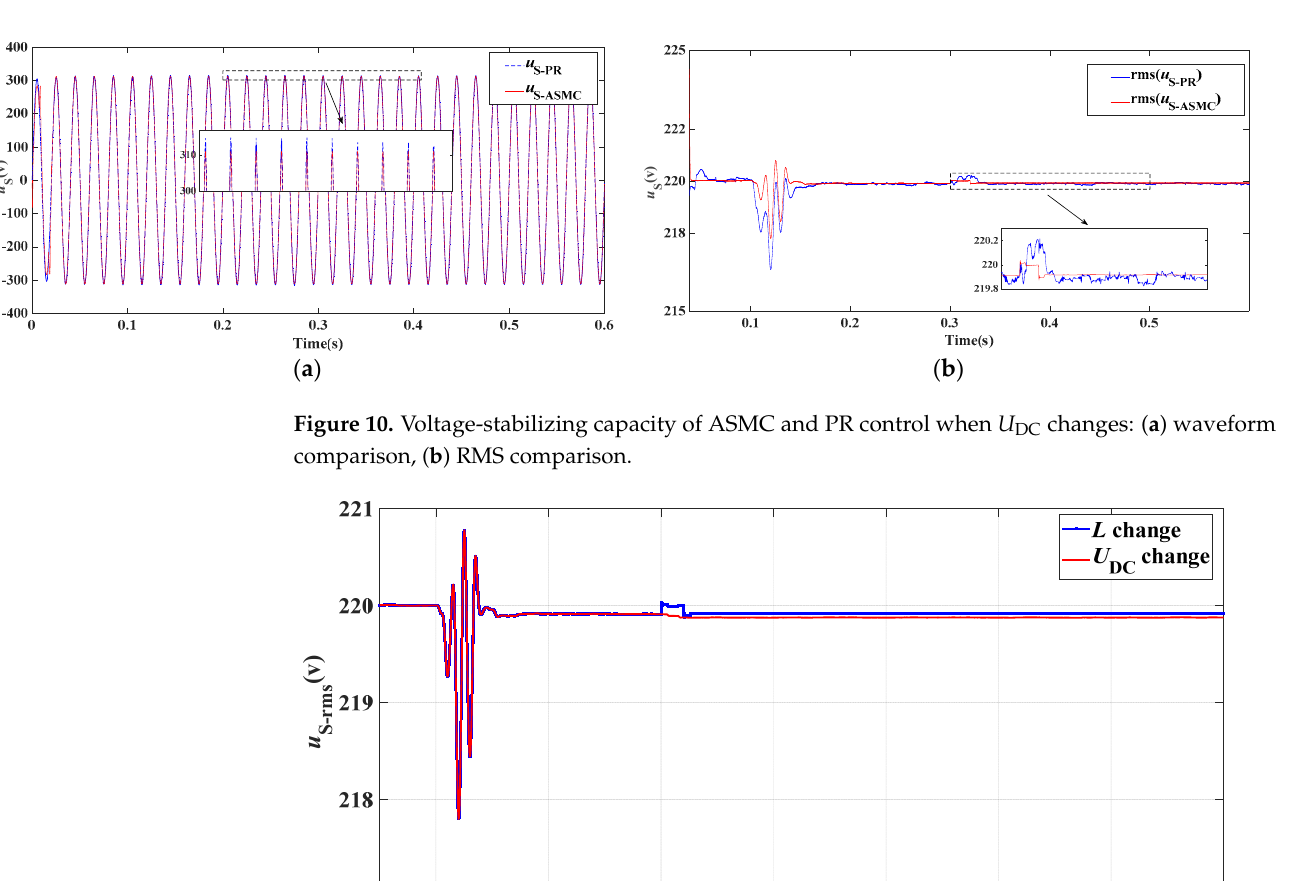
u uses a saturation function.